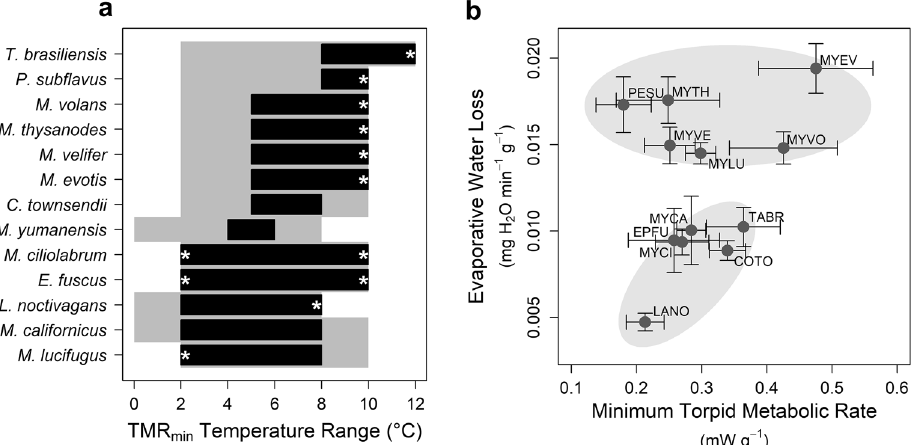
Figure 3. Variation in temperature responses, minimum torpid metabolic rate (TMR min ), and evaporative water loss (EWL) among species. ( a ) Minimum defended temperature and the range of temperatures which resulted in TMR min varied among species. Grey area represents the temperature range over which the species was tested, the black bars represent the temperature range over which TMR min was measured. The lower end of the black boxes represents the estimated minimum defended temperature, but note that asterisks highlight cases where the TMR min temperature range reached either the upper or lower limit of the tested temperature range. ( b ) Within the range of temperatures at which TMR min was measured, evaporative water loss (EWL) varied among species (high and low EWL clusters) but not TMR min . Error bars indicate standard error and grey ovals are presented for visual interpretation. Species codes indicate the first two letters of the genus and the specific epithet (see Table